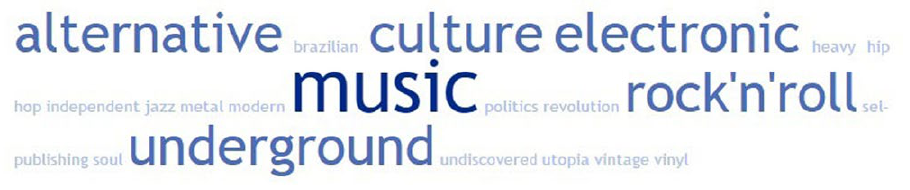
Figure 1: Tag crowd of the terms used in the sampled programming description